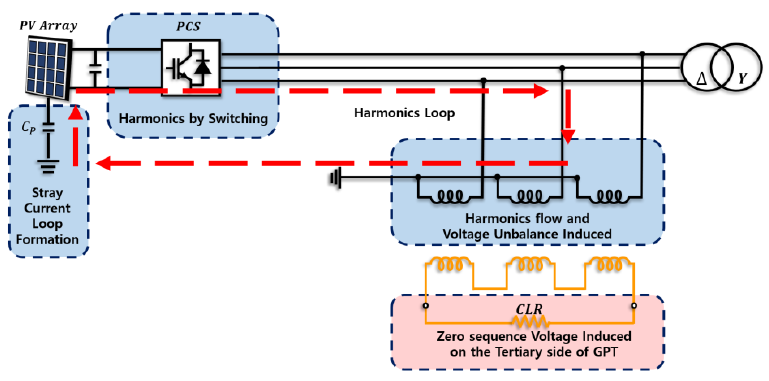
Figure 7. GPT zero-phase voltage factor.